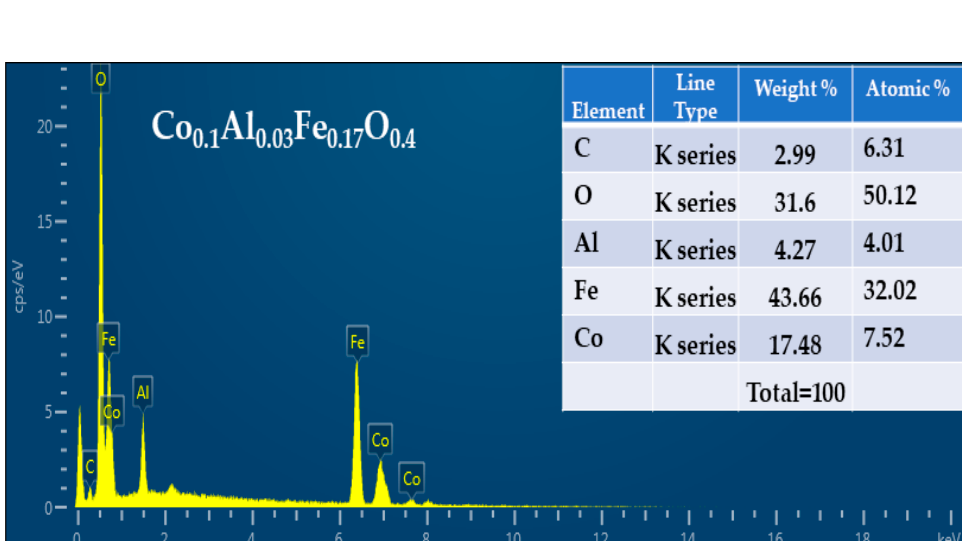
Figure 8. Energy ‐ dispersive X ‐ ray spectra of CoFe 2 O 4 and Co 0.1 Al 0.03 Fe 0.17 O 0.4. Figure 8. Energy-dispersive X-ray spectra of CoFe